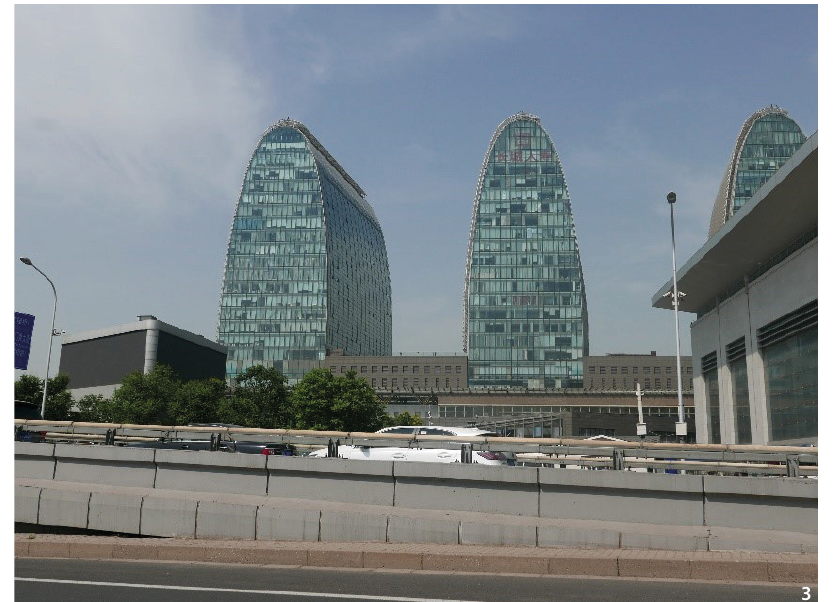
Figure 3 Contemporary architecture, to create metropolitan heritage of tomorrow